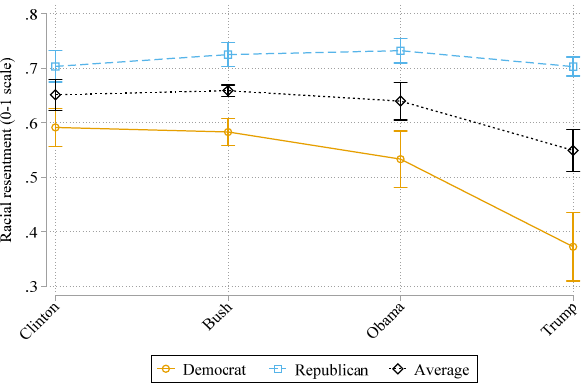
Figure 3. Racial resentment among White respondents, by presidential administration and last presidential vote. Confidence intervals are at the 95%